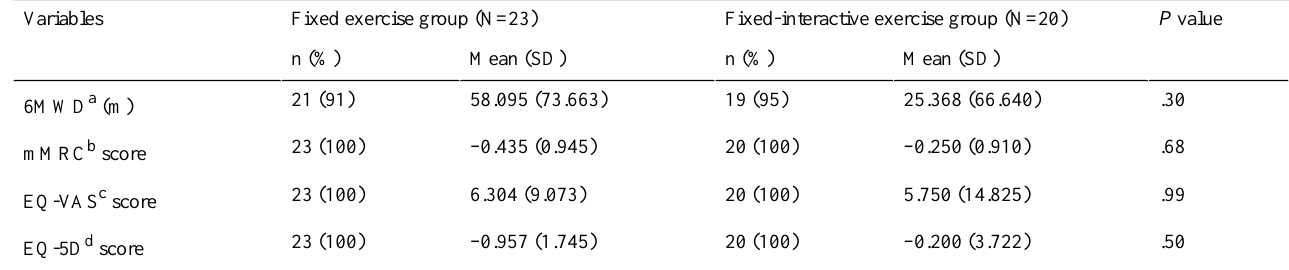
Table 3. Preintervention and postintervention changes in outcome variables between the 2